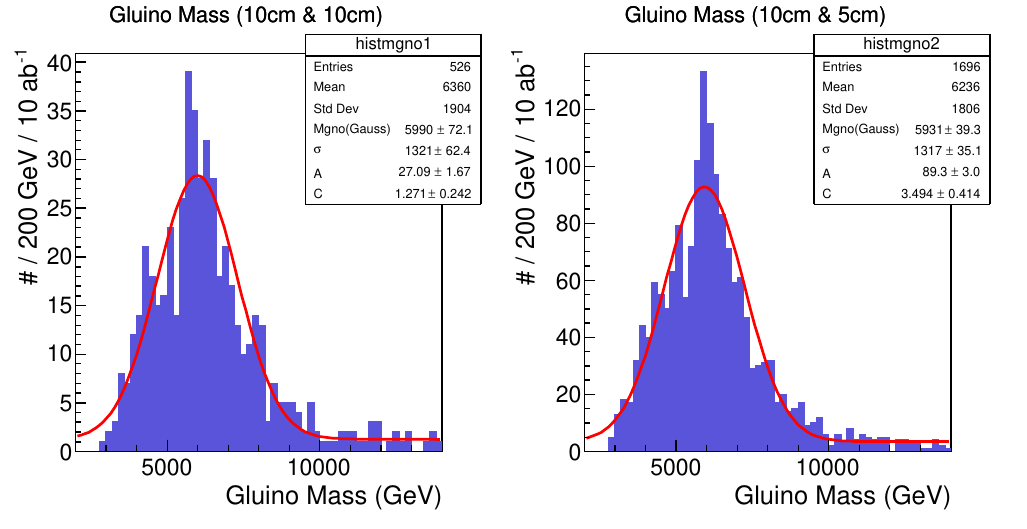
Figure 10 . Distribution of m (rec) in a single experiment with the integrated luminosity of L = 10 ab (cid:0) 1 .